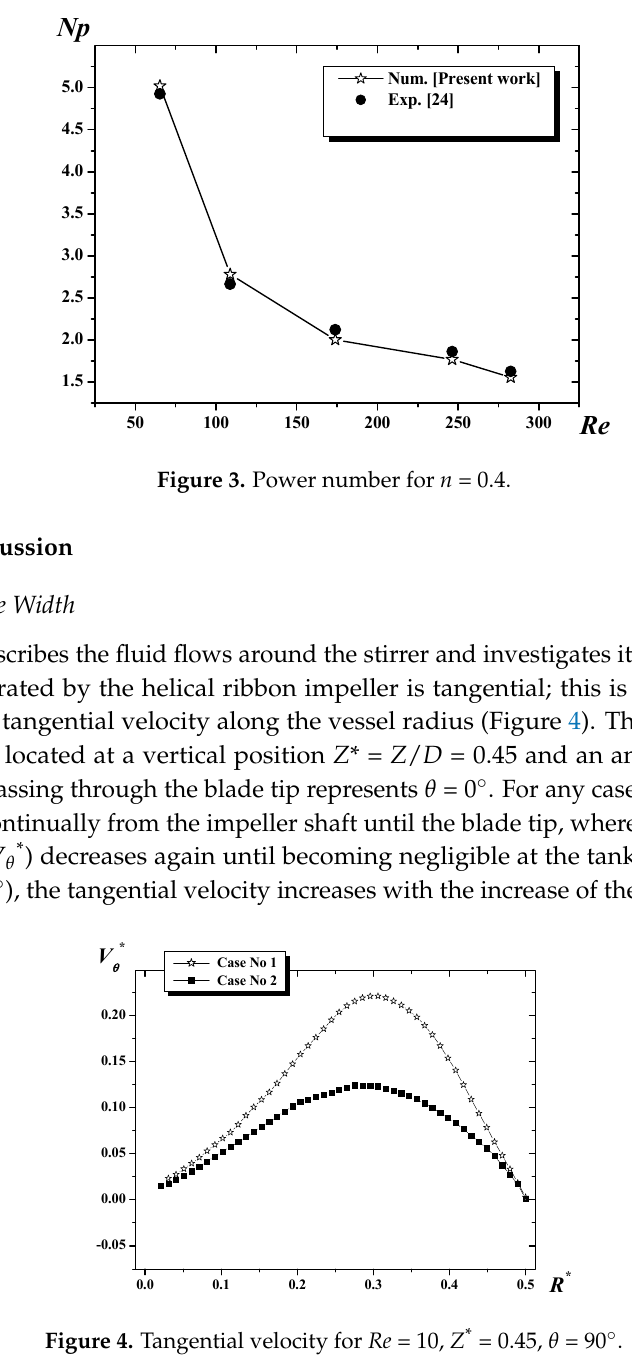
Figure 3. Power number for n = 0.4.